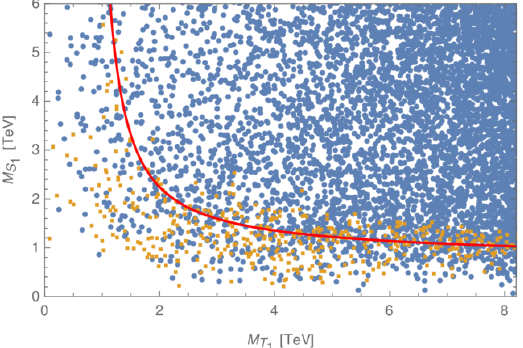
Figure 4 . Mass of the lightest top partner mixing with the t R ( M S ) versus mass of the lightest top 1 partner mixing with the q L ( M T ), neglecting EWSB corrections, in the two-layer model. Orange 1 (blue) points have a Higgs mass within (outside) the range 120 GeV < m h < 130 GeV. The